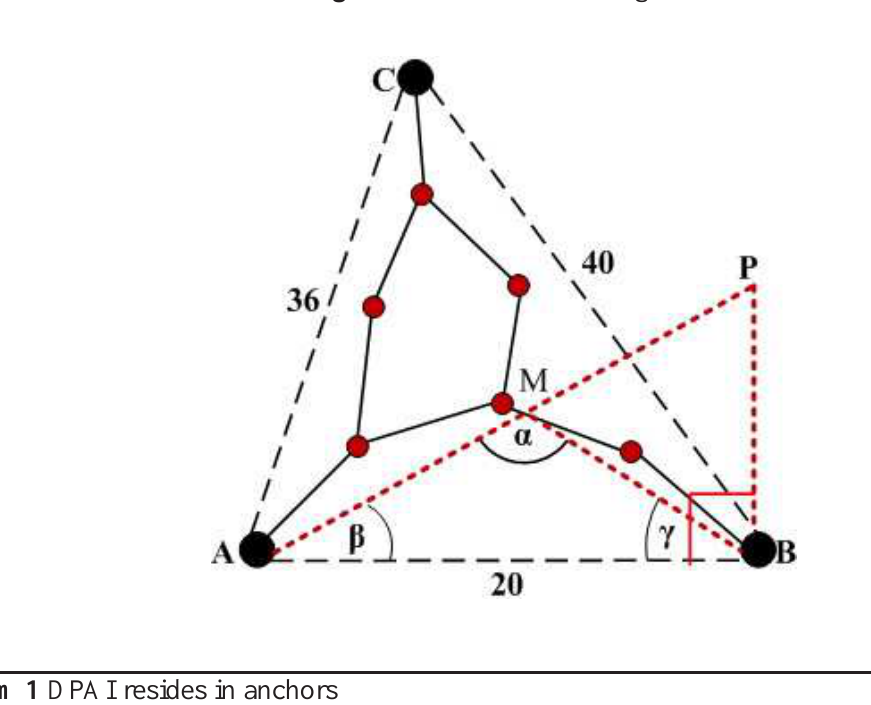
Algorithm 1 DPAI resides in